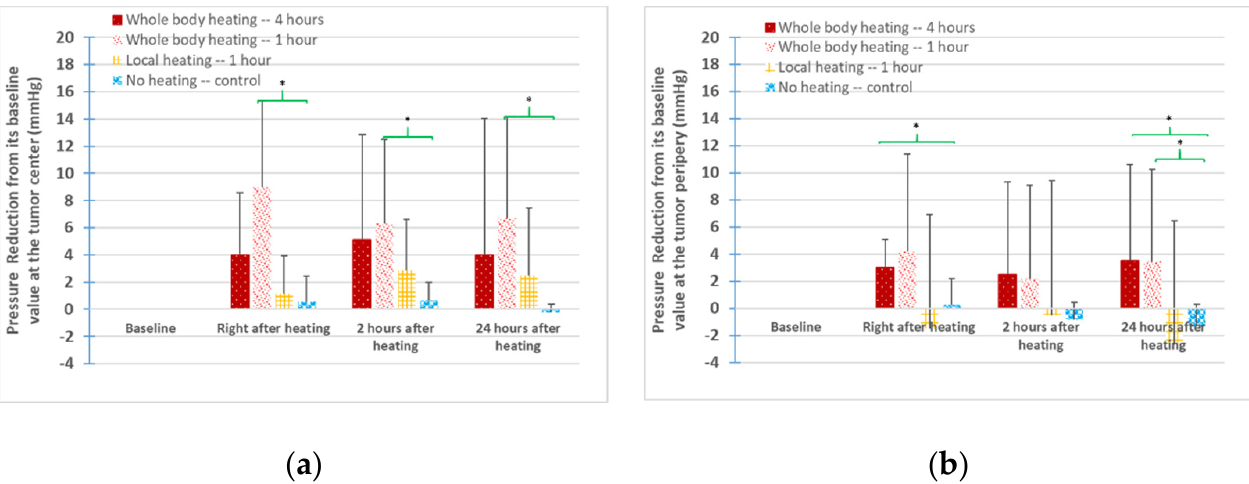
Figure 5. The mean values and standard deviations of the pressure reductions from the baseline values in the four tumor groups. ( a ) The left panel represents the IFP reduction at the tumor center, while ( b ) the right panel shows the IFP reduction at the tumor periphery. * denotes that a p -value < 0.05 between a heating group and the control group at the same time instant.